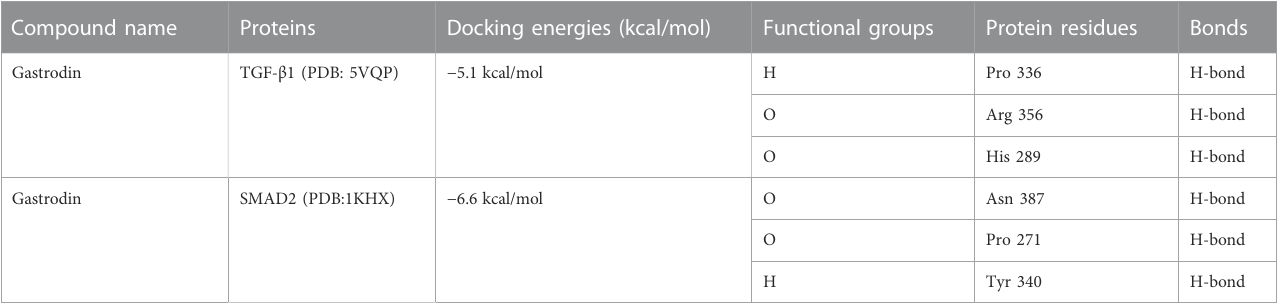
TABLE 1 Docking energies and bonds between gastrodin and